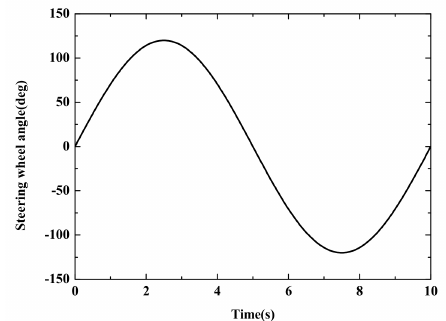
Figure 7. The Steering